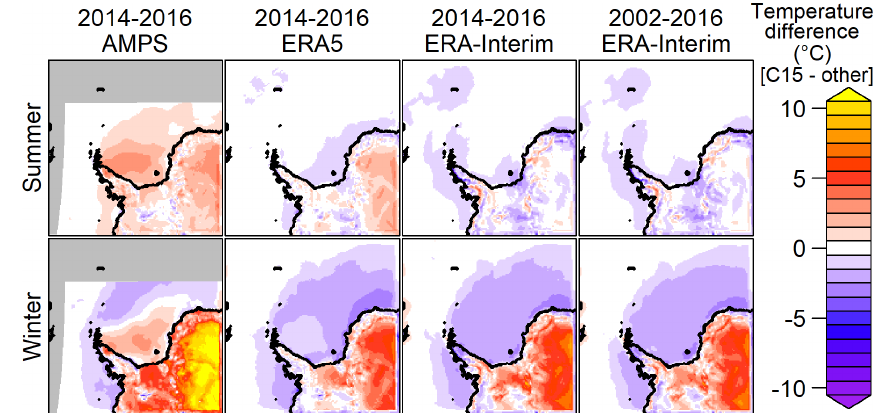
Figure 3. The 2m temperature difference (C15 minus AMPS, ERA5, and ERA-Interim) for the years 2014–2016 and 2002–2016. Summer (October–March, top) and winter (April–September, bottom) are shown separately. The grey area is outside the AMPS domain.